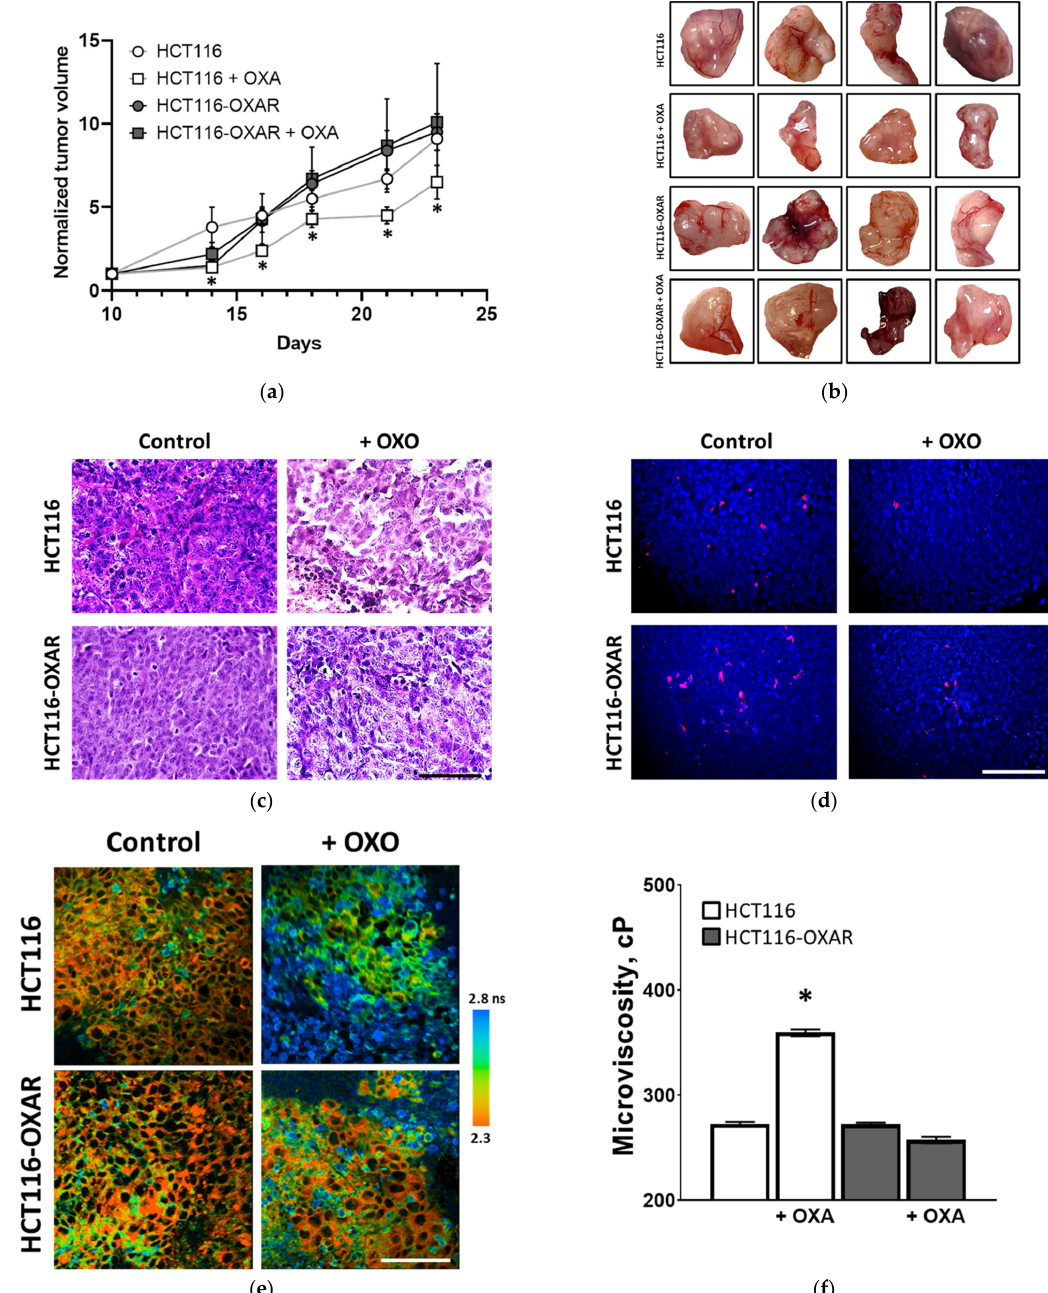
Figure 6. Membrane viscosity in oxaliplatin-sensitive HCT116 and resistant HCT116-OXAR tumors. ( a ) Dynamics of growth of untreated HCT116 and HCT116-OXAR tumors and tumors treated with oxaliplatin (7.5 mg/kg, seven doses for two weeks). Tumor volumes were normalized to the values of 10th day. Mean ± SEM, n = 4 tumors.*, p ≤ 0.05 with untreated HCT116 tumors. ( b ) Photographs of tumors. ( c ) Histopathology of HCT116 and HCT116-OXAR tumors on 23 day of growth after treatment with oxaliplatin and untreated controls. H&E-staining. Bar is 100 µ m, applicable to all images. Initial magnification is 40 × . ( d ) IHC for Ki-67 (red) overlapped with DAPI (blue) staining. Bar is 100 µ m, applicable to all images. Initial magnification is 40 × . ( e ) Representative FLIM images of HCT116 and HCT116-OXAR tumors in vivo after chemotherapy with oxaliplatin and untreated controls. Imaging was performed after i.v. injection of BODIPY 2 at 3 mg/kg. Ex. 850nm, reg. 500–550nm. Bar is 40 µ m, applicable to all images. ( f ) Quantification of viscosity of the tumors. Mean ± SEM, n = 4 tumors. Measurements were done in 20–30 cells in each field of view. *, p = 0.0002 with untreated HCT116